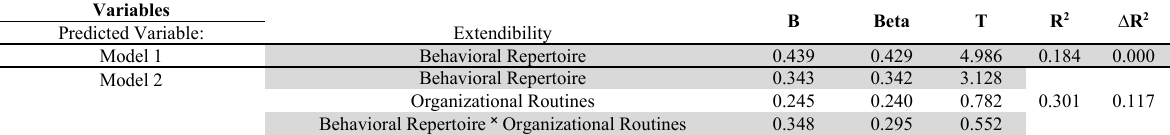
The results of Hierarchical Regression Analysis of the moderating effect of organizational routines on the relationship between behavioral repertoire and Extendibility